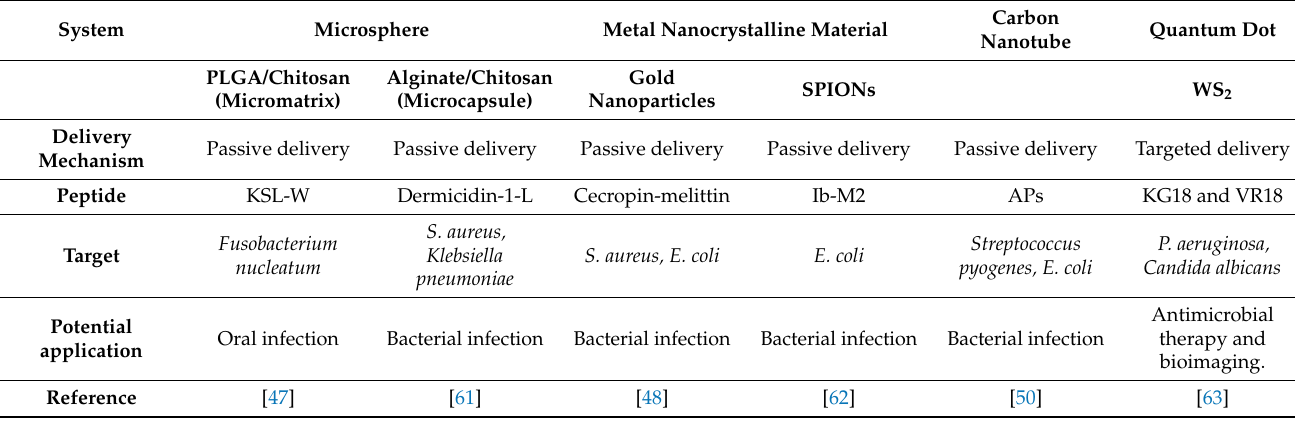
Table 3. An overview of AMPs contained in nanodrug delivery systems composed of microspheres, metal nanocrystalline materials, carbon nanotubes, and quantum dots and their potential